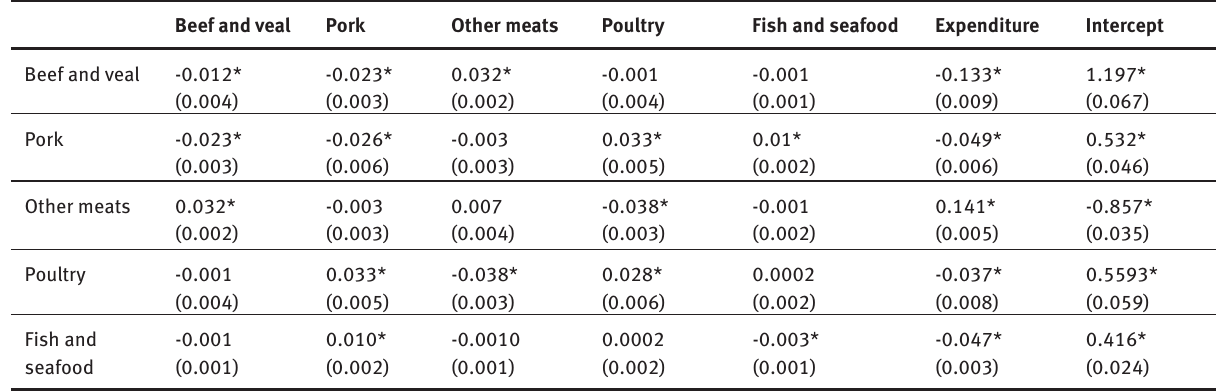
Table 4: Coefficient estimates for disaggregate model1 Beef and veal Pork